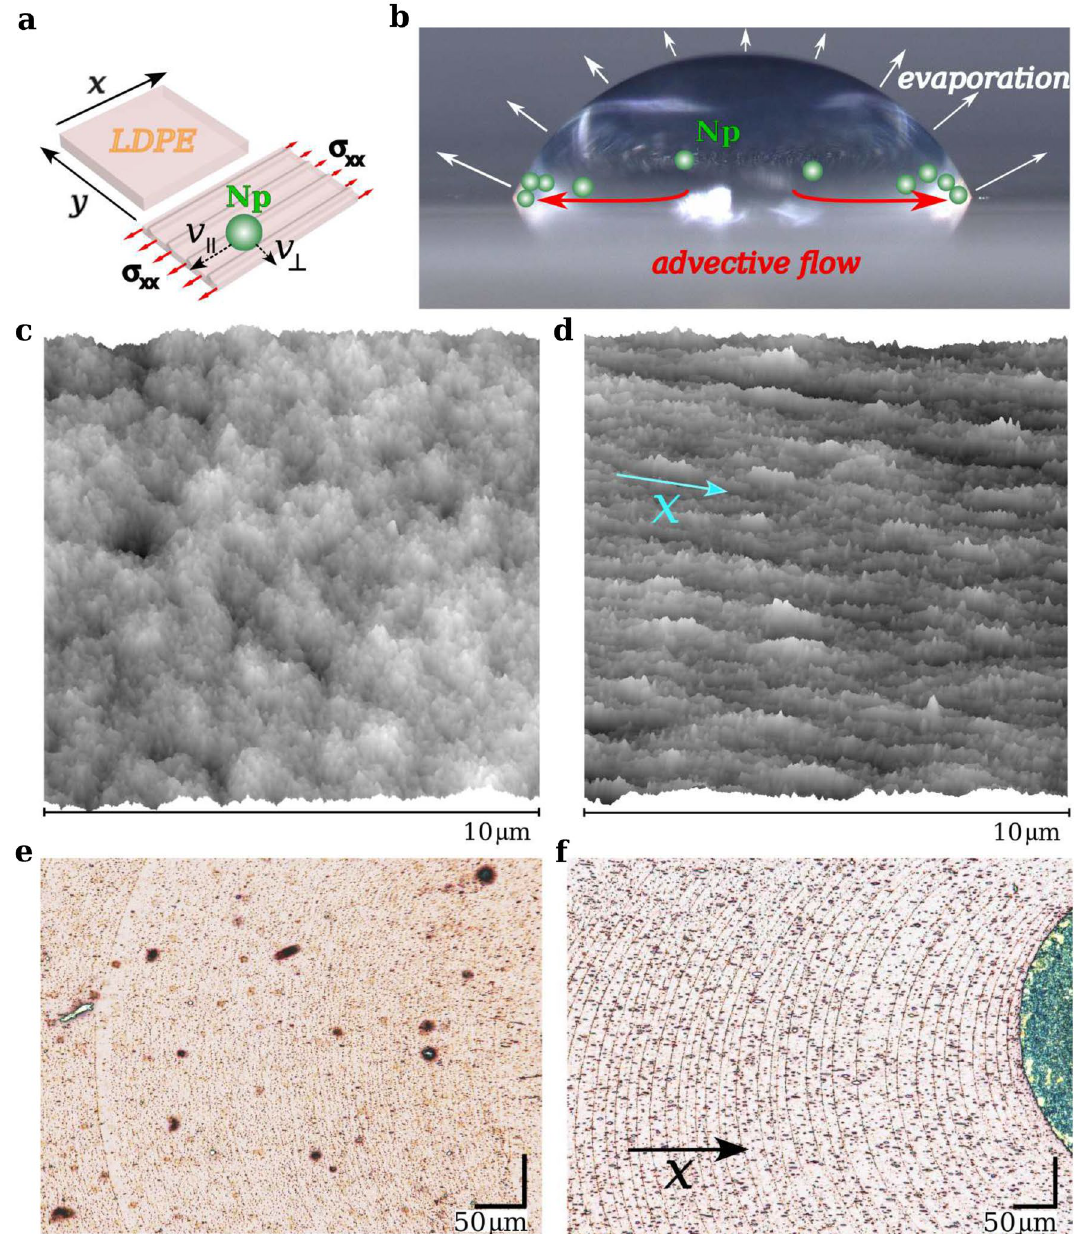
Figure 1. Scheme for obtaining multi-ring stains from a dried droplet of magnetic liquid on LDPE film. ( a ) Obtaining a stretched substrate after the application of normal stress σ xx in the x-axis direction. At the bottom of v the droplet layer, the effective nanoparticle speed v . ( b ) Evaporating droplet and magnetic nanoparticles ⊥ �= � (green symbols) in an advective flow due to the evaporation. ( c ) AFM image of the surface of the pristine LDPE. ( d ) AFM image of the stretched LDPE film surface where the original sample width of 1 cm was stretched to 5 cm. The arrow shows the direction of the x -axis in which the film was stretched. ( e ) Optical microscope image of the stains from the dried droplet on pristine LDPE. ( f ) Same as in ( e ) but on the stretched LDPE. The arrow shows the direction of stretching as on panel ( d ). The average height of the nanoparticle deposit, in panels ( e ) and ( f ), ranges from 30 to 100 nm. The optical visualization of them is possible due to the light scattering effect. This is also reason for the numerous dark spots visible outside the ring structures, which represent interior LDPE film